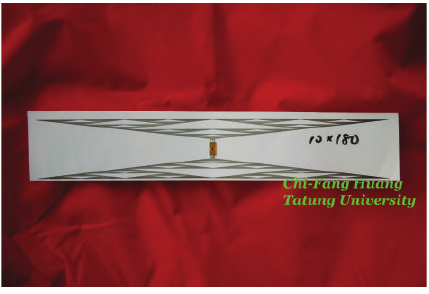
Figure 4: Simulation model of the wideband reader antenna.